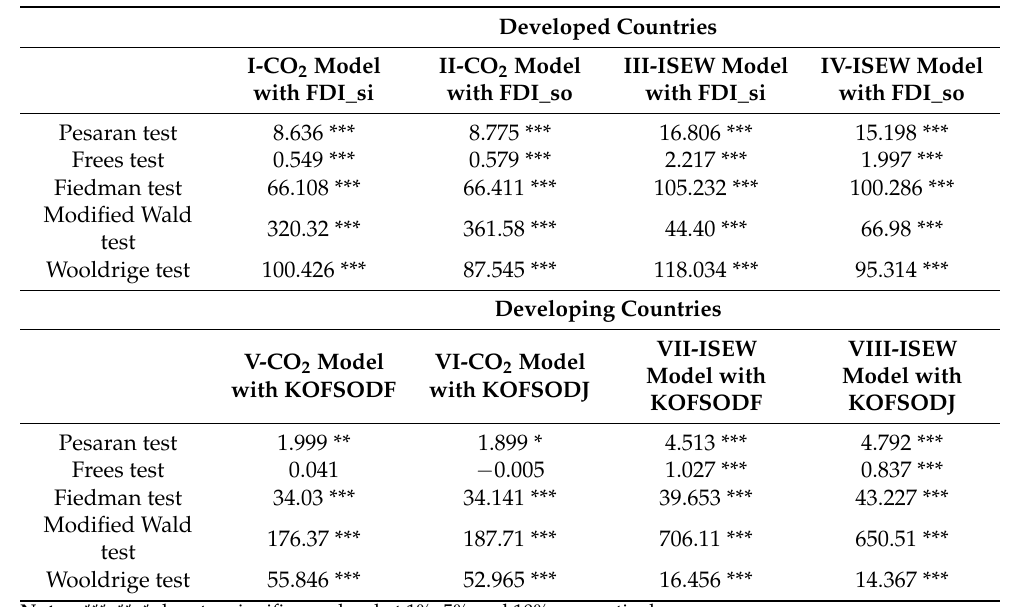
Table 10. Specification